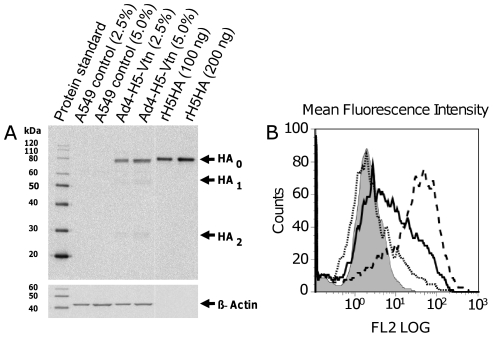
Ad4-H5-Vtn virus infection of A549 cells induced H5 HA protein expression as detected by Western blot and flow cytometry analysis.In the case of western blot analysis (A), A549 cells were infected in suspension with clarified crude lysate of Ad4-H5-Vtn virus from the 14th passage. The cell extracts, 2.5% and 5%, were subjected to SDS-PAGE in 4–12% Bis-Tris gel, blotted onto nitrocellulose membrane and probed with anti-1194 H5HA polyclonal sheep antibody. Lysates as indicated, from uninfected A549 cells were used as negative control. Recombinant His tagged H5HA1203/2004 100 ng and 200 ng proteins were used as positive controls. β-actin was used as loading control. HA0 refers to full length H5HA; HA1 and HA2 represent the proteolytically cleaved form of HA. In the case of flow cytometry (B), A549 cells were infected with a dose titration (vp/mL) of the Ad4-H5-Vtn vector: dotted line, 5×106; solid line, 5×107; dashed line, 5×108. Infected cells were removed and subsequently incubated with primary anti-H5HA and secondary goat anti-IgG PE antibodies. A negative control, A549 cells infected with Ad4wt virus (5×108 vp/mL) was included; grey fill.